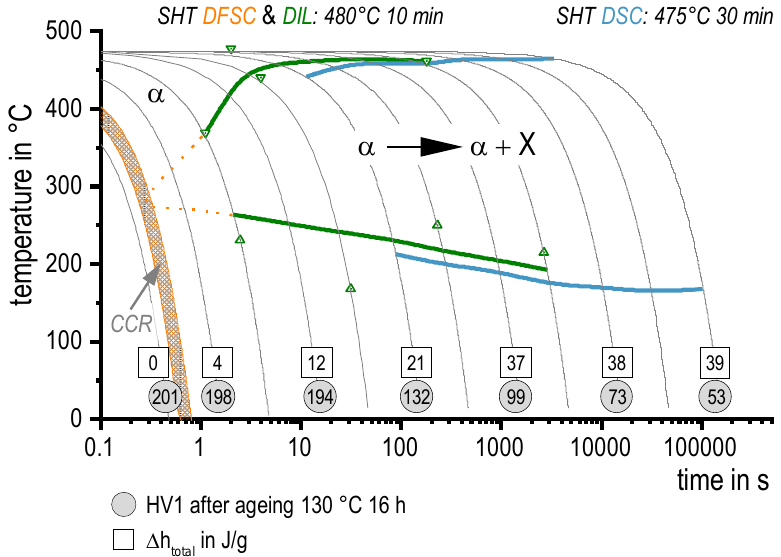
Figure 9. Continuous Cooling Precipitation Diagram of AA 7068 from DSC, dilatometry (DIL), and DFSC. Within the reaction α → α + X, the X comprises any quench induced phase.